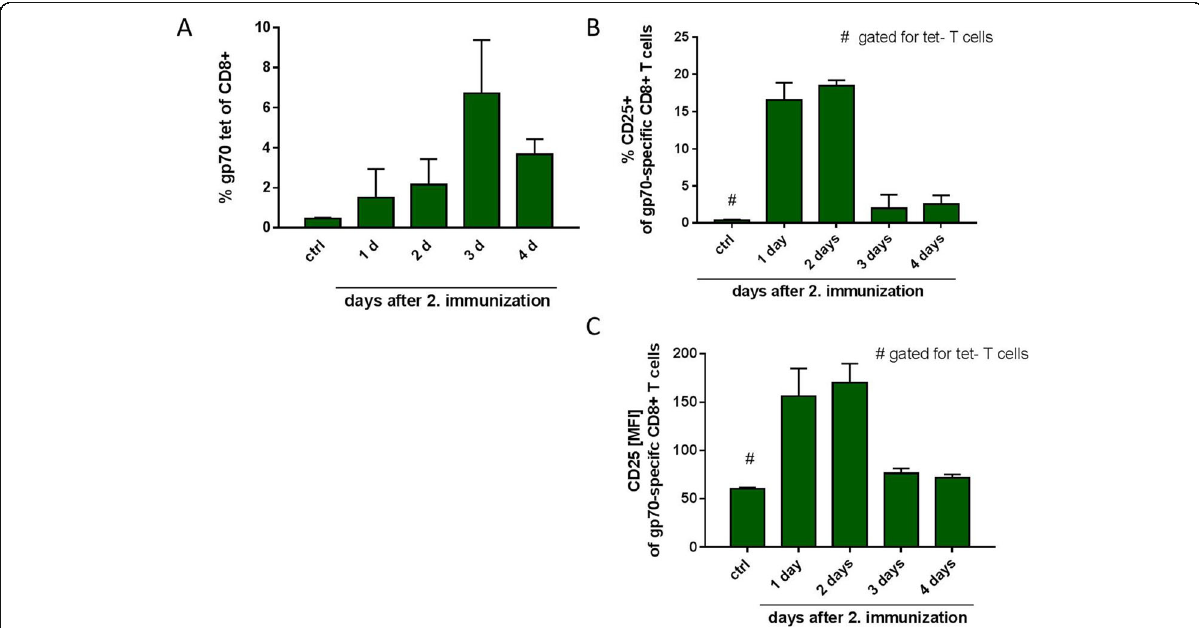
Fig. 2 Proliferation and activation of T cells after two cycles of RNA-lipoplex vaccination. a Fraction of gp70 tetramer-positive CD8 + spleen T cells showing peak proliferation at day three. b / c Corresponding to the FDG uptake elevation, the activation marker CD25 (MFI/ %) can be detected before the peak of T cell proliferation and returns almost to baseline at day